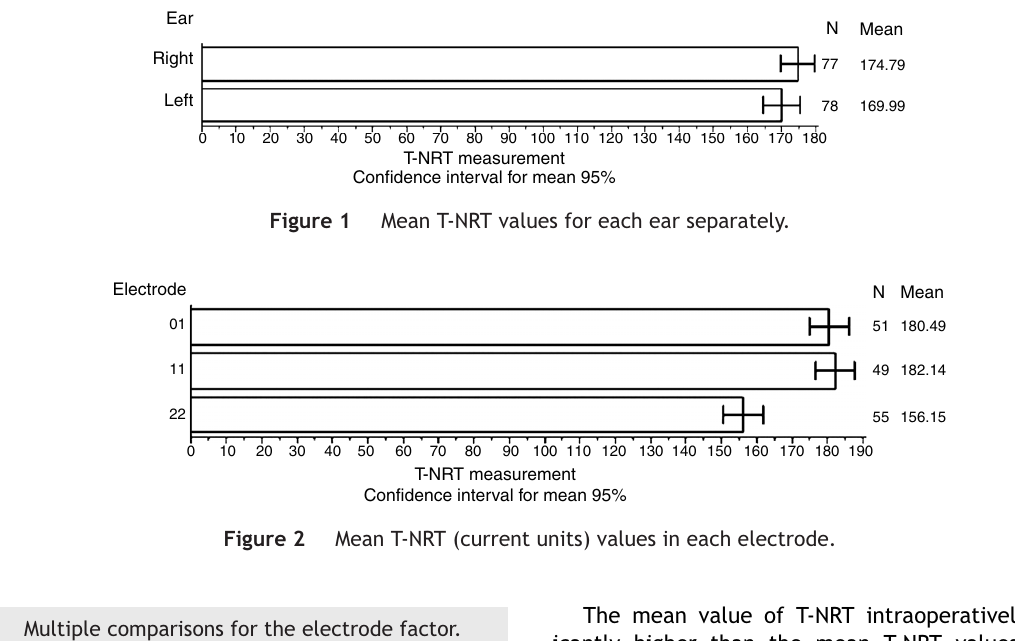
Multiple comparisons for the electrode factor. Multiple comparisons --- electrode factor